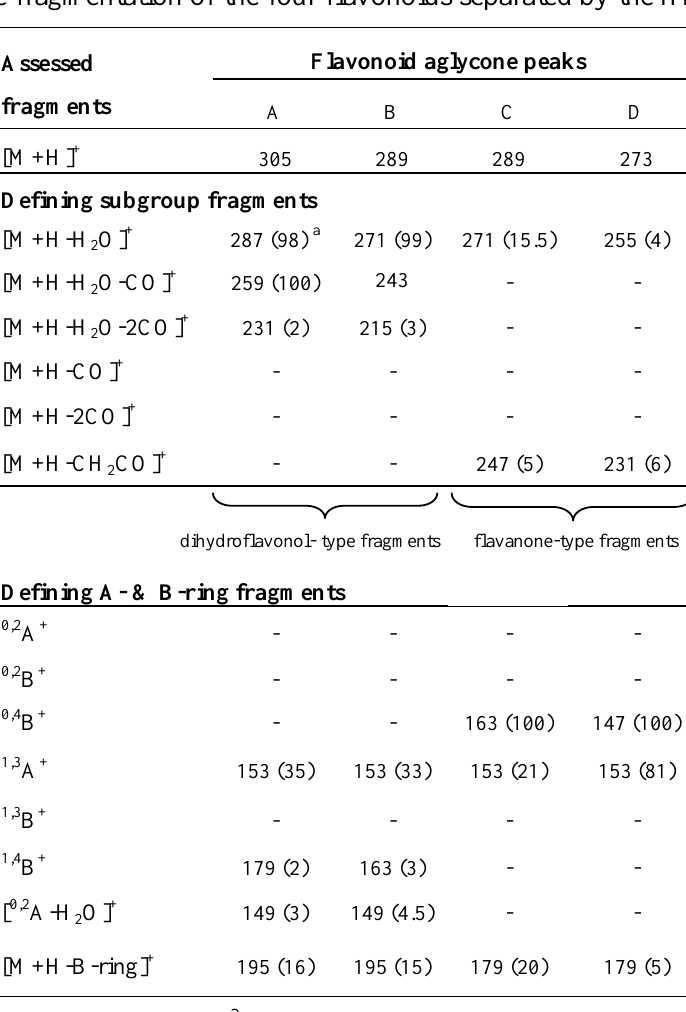
Table 3. The fragmentation of the four flavonoids separated by the HPLC